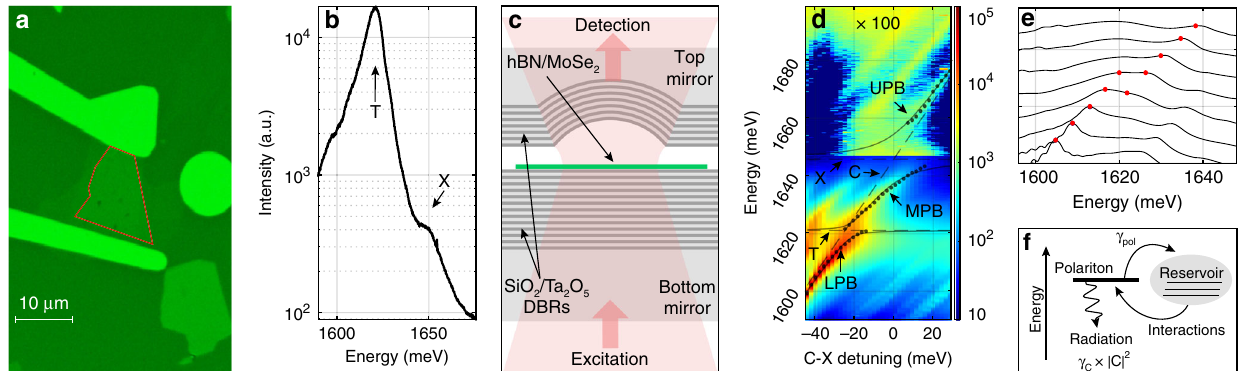
Fig. 1 Strong light – matter coupling with MoSe 2 monolayer. a Optical microscope image of the MoSe 2 fl ake, highlighted with a red border, encapsulated in hBN and clamped with two golden contacts on top of the bottom mirror. b PL emission of the fl ake under off-resonant excitation with exciton (X) and trion (T) peaks highlighted. The observed order of magnitude difference for the intensity of the PL of the trion relative to the exciton arises from fast neutral exciton to trion states relaxation processes due to scattering with phonons and electrons. c Scheme of experiment for resonant excitation of the open cavity in the transmission geometry. d PL emission as a function of the detuning between bare cavity LG 00 mode (C) and exciton (X) plotted in logarithmic colour scale; black points (dots) are experimental peak positions of the polariton resonances extracted from the fi tting of experimental spectra at each detuning with a Gaussian; solid lines are theoretical polariton branches. Higher order transverse LG modes are also observed on the left and right-hand side of LG 00 polariton states. e Normalised PL spectra around trion resonance, showing anticrossing behaviour. f Schematic showing emission and absorption of driven polariton resonance and interactions with the reservoir of trions and excitons.